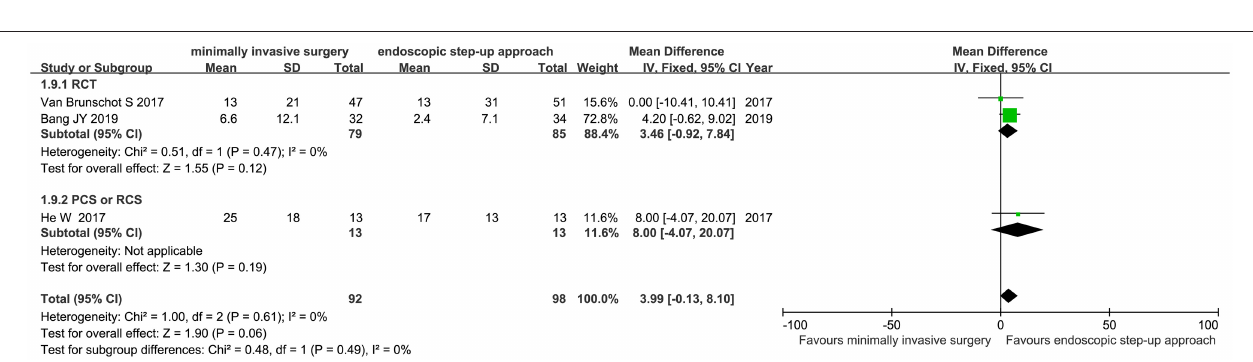
FIGURE 9 | Forest plots for the length of hospital for minimally invasive surgery and endoscopic step-up approach. IV, inverse variance; Fixed, a fixed effects model; CI, confidence intervals.